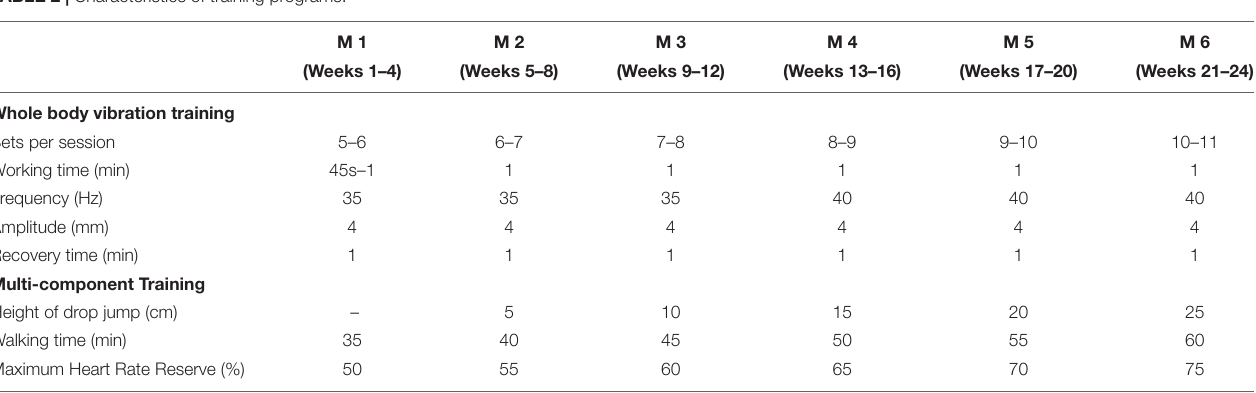
TABLE 2 | Characteristics of training